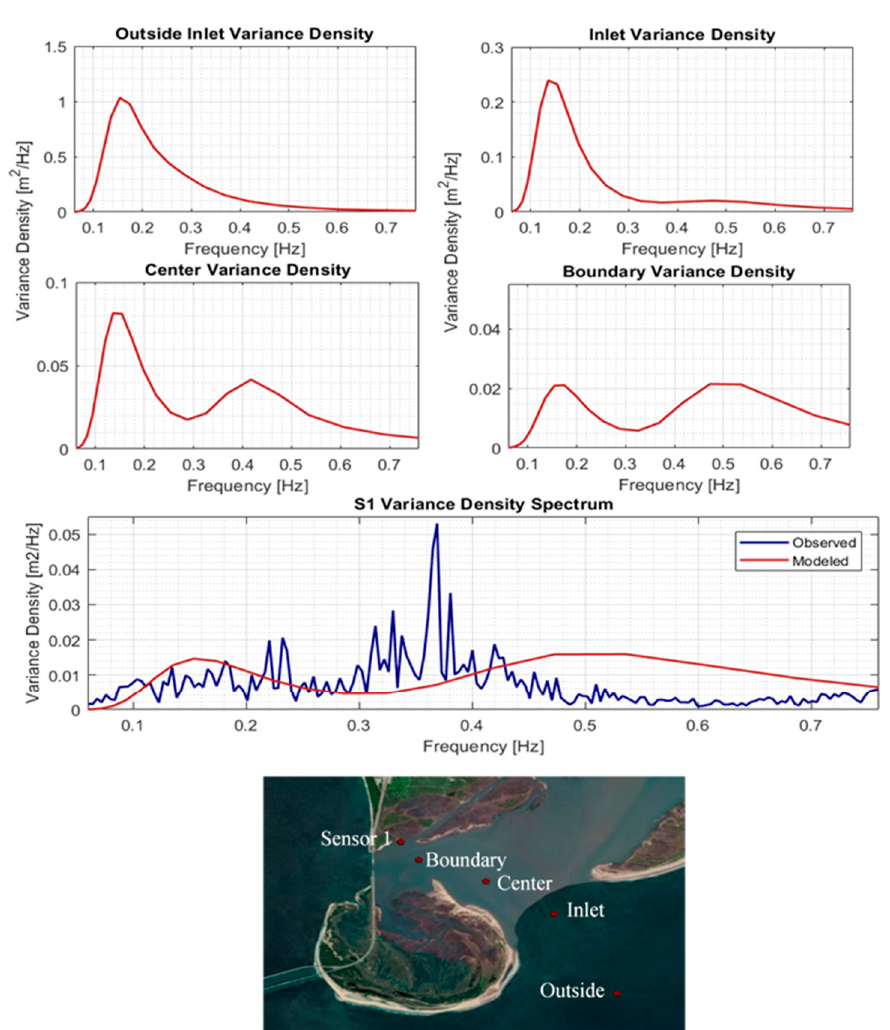
Figure 12. Variation in wave spectral density (determined for the hour of 23:00 26 September 2015) across the research site leading up to the Sensor 1.